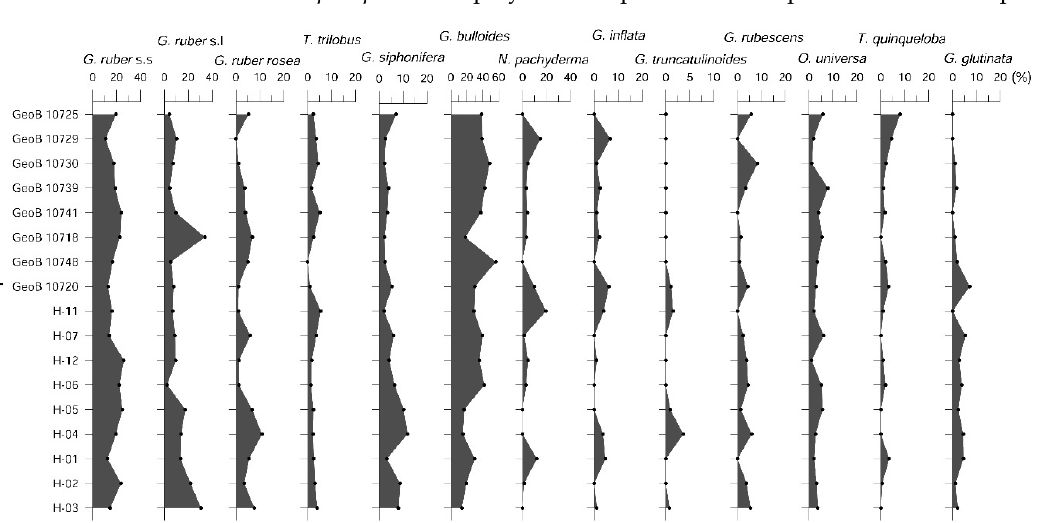
Figure 2. Planktonic foraminifera species abundances in core-top samples from the eastern Mediterranean. The labels in the vertical axis are representative of the core-top locations presented in Table 1.